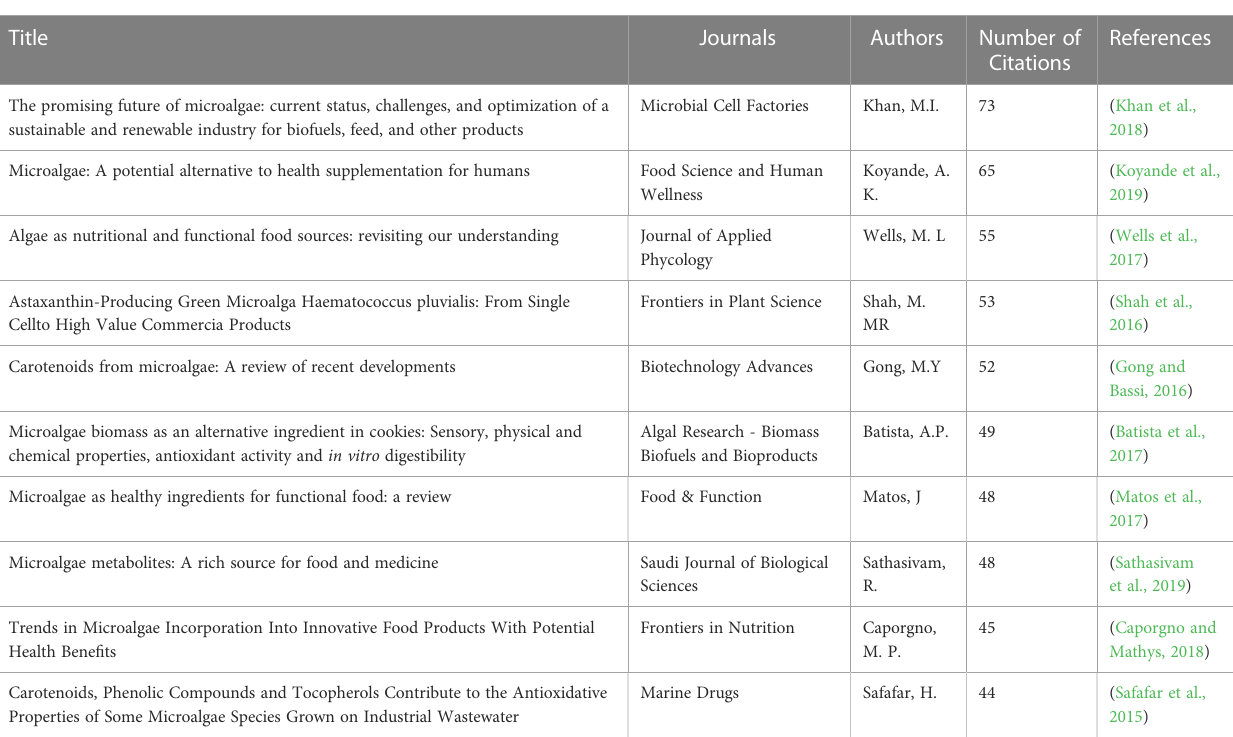
TABLE 3 Documents with the highest citations in global research.